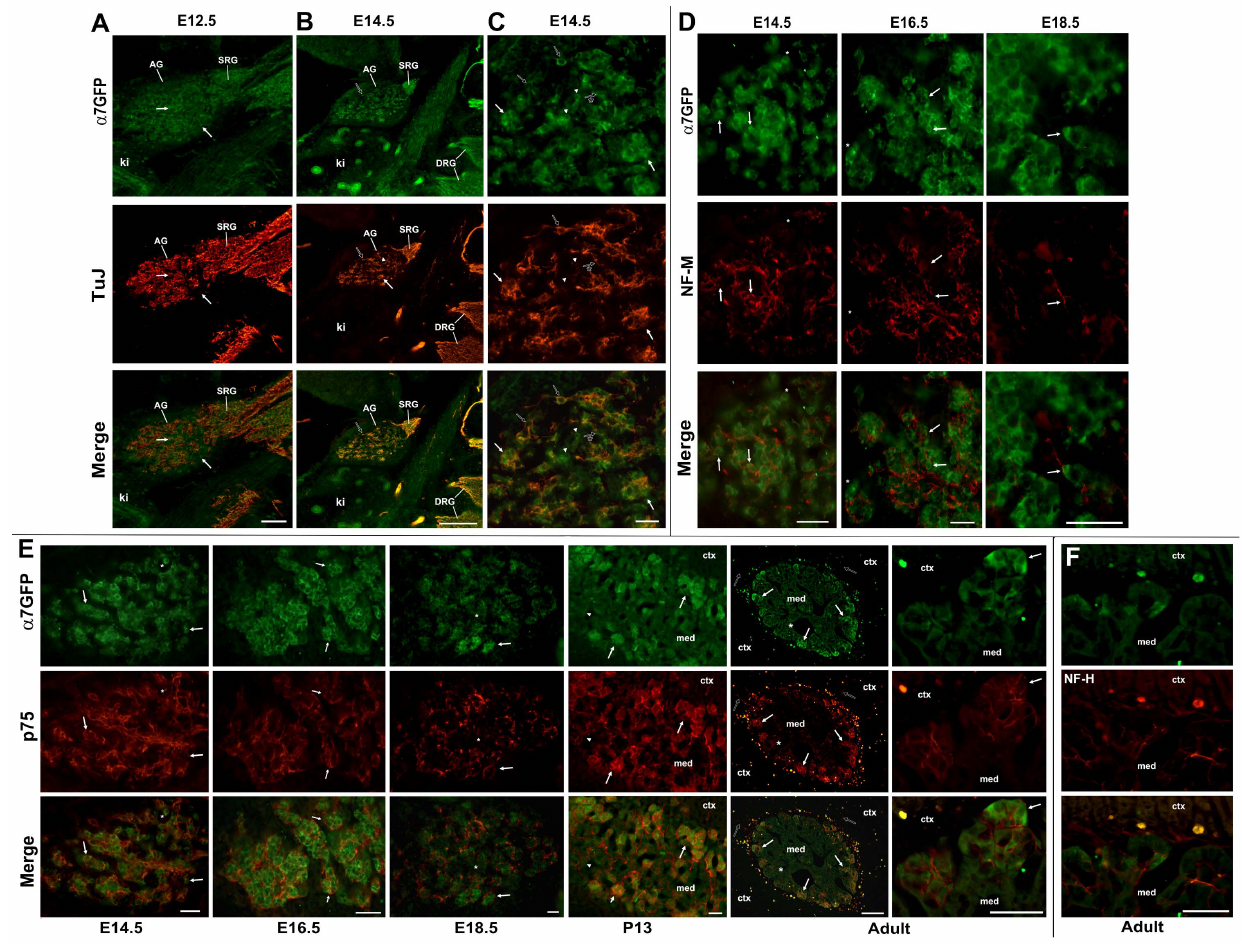
Figure 5. Adrenal gland innervation and expression of a 7 G . Adrenal glands at various times of development as indicated were labeled for co- expression of a 7 G as measured by anti-GFP immunofluorescence ( a 7GFP, green) and various peripheral nerve markers as indicated (red). A ) The same section from Figure 2a for the E12.5 adrenal gland is shown with co-labeling for immature neuronal marker, beta-III tubulin (TuJ). TuJ labeling reveals penetration of efferents into the developing adrenal gland (AG) and staining in the suprarenal sympathetic ganglion (SRG). With rare exceptions (arrows), there is almost no overlap in cells or processes expressing these respective markers. The kidney is identified (ki). B ) The E14.5 AG exhibits consolidation of the TuJ staining into fibers that localize to the site of a 7 G labeled cell accumulation. Rare cells are labeled by both a 7 G and TuJ (black filled arrow). Note the coincident staining between these markers in the DRGs, but only very rare TuJ identified filaments in the kidney. C ) Increased magnification of the E14.5 adrenal gland shown in B. In these images the cell exhibiting both a 7 G and TuJ labeling is identified by the black arrow. Aggregated a 7 G labeled cells with the presence of extensive TuJ-labeled afferents is identified for two of these clusters by arrows. Also present are a 7 G -labeled cells with no apparent association with TuJ labeled afferents (arrow heads). In some instances the TuJ identified afferents form fine fibers with varicosities that appear to wrap a 7 G stained cells (black filled arrow with asterisk). D ) Shown are images from the AG medulla at the developmental stage indicated double labeled for a 7 G or neurofilament-M (NF-M). Arrows identify cells expressing a 7 G that appear to also be in association with NF-M stained afferents. Note the consolidation and apparent trimming of NF-M afferents and their association with clusters of a 7 G cells. E ) Sections of the AG at the indicated developmental time are double labeled with a 7 G and the neurotrophin receptor subunit p75. Although no co-labeling of cells or processes with a 7 G and p75 was identified, there is extensive association between a 7 G cells and p75 labeled afferents that persists into the post-natal period (P13 shown) and becomes refined to include almost preferentially cell clusters of the adrenal medulla identified by the a 7 G -labeled cell clusters in the adult (arrows). This is particularly evident in the adjacent panels showing these clusters at increased magnification. There are however, some cell clusters in the adult that exhibit weak or no a 7 G immunostaining that are innervated by p75 stained fibers (asterisk). Occasionally p75-labeled processes also extend into the adrenal cortex (open arrow). These processes are not detected by anti-GFP staining. F) The adult immunostaining by the neurofilament protein-H (NF-H) exhibits less specificity for afferents interacting with a 7 G stained cells when compared to those afferents identified by p75. Abbreviations: AG, adrenal gland; ctx, adrenal cortex; ki, kidney; med, adrenal medulla; SRG, suprarenal ganglion. Scale bar =100 m m (A,B, E adult) or 50 m